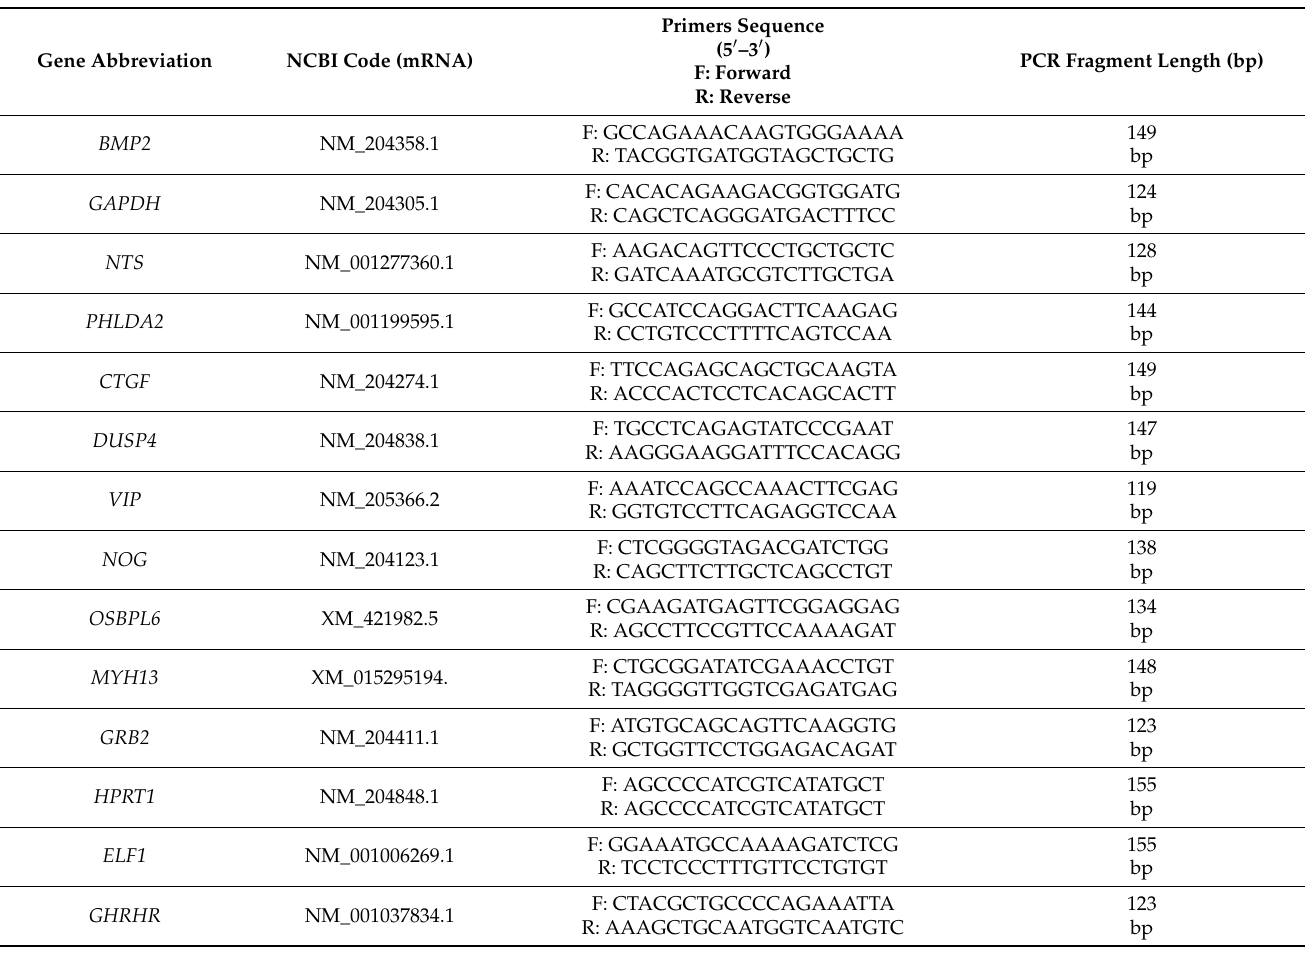
Table 2. List of NCBI codes (mRNA) for the 14 genes used in the current study, their primers, and their expected PCR amplified sizes in base pairs